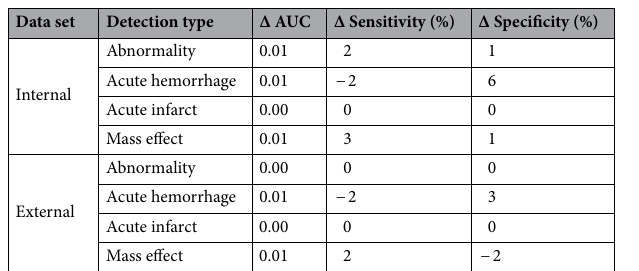
Table 4. Contribution of optional contrasts to classifier performance. Positive values denote that the model performance was higher with all available contrasts than with only mandatory contrasts.